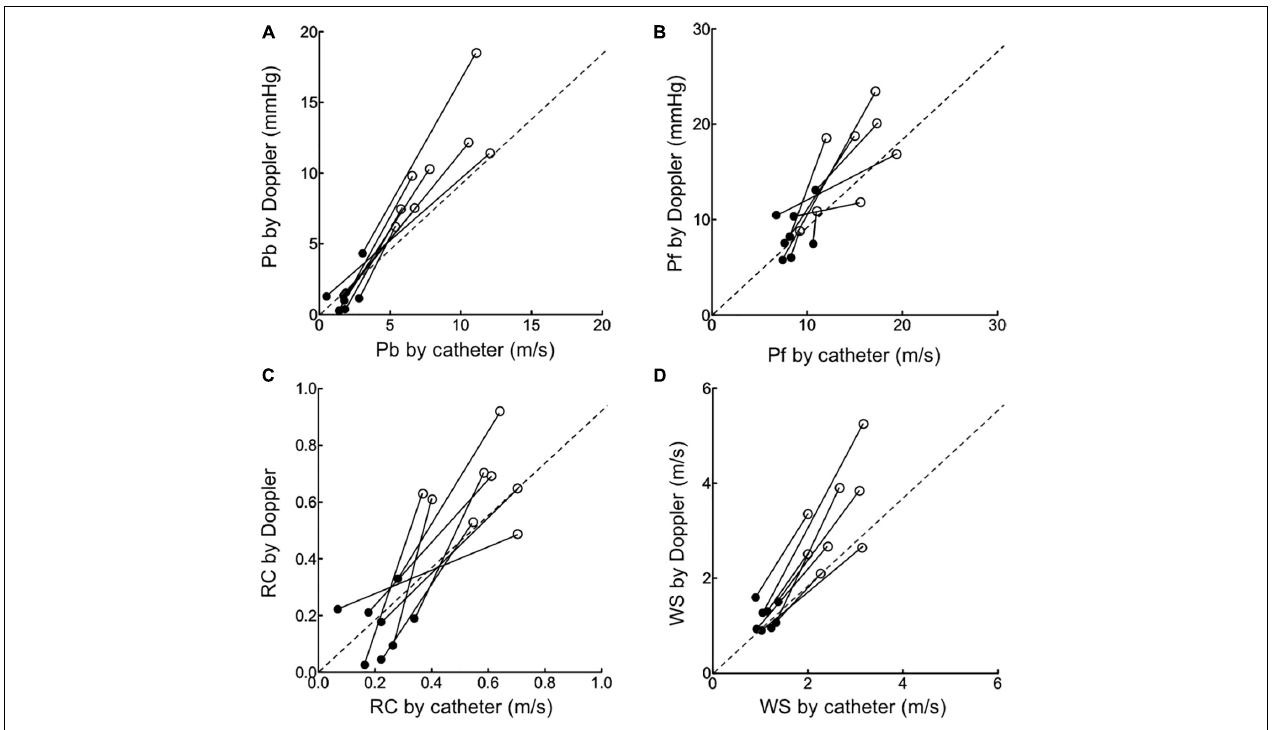
FIGURE 4 | The changes in wave reflection and arterial stiffness indices induced by pulmonary hypertension. The changes in echo-Doppler derived Pb (A) , Pf (B) , RC (C) and WS (D) from baseline (black circle) to pulmonary hypertension state (open circle) were compared to those in corresponding catheter derived indices.